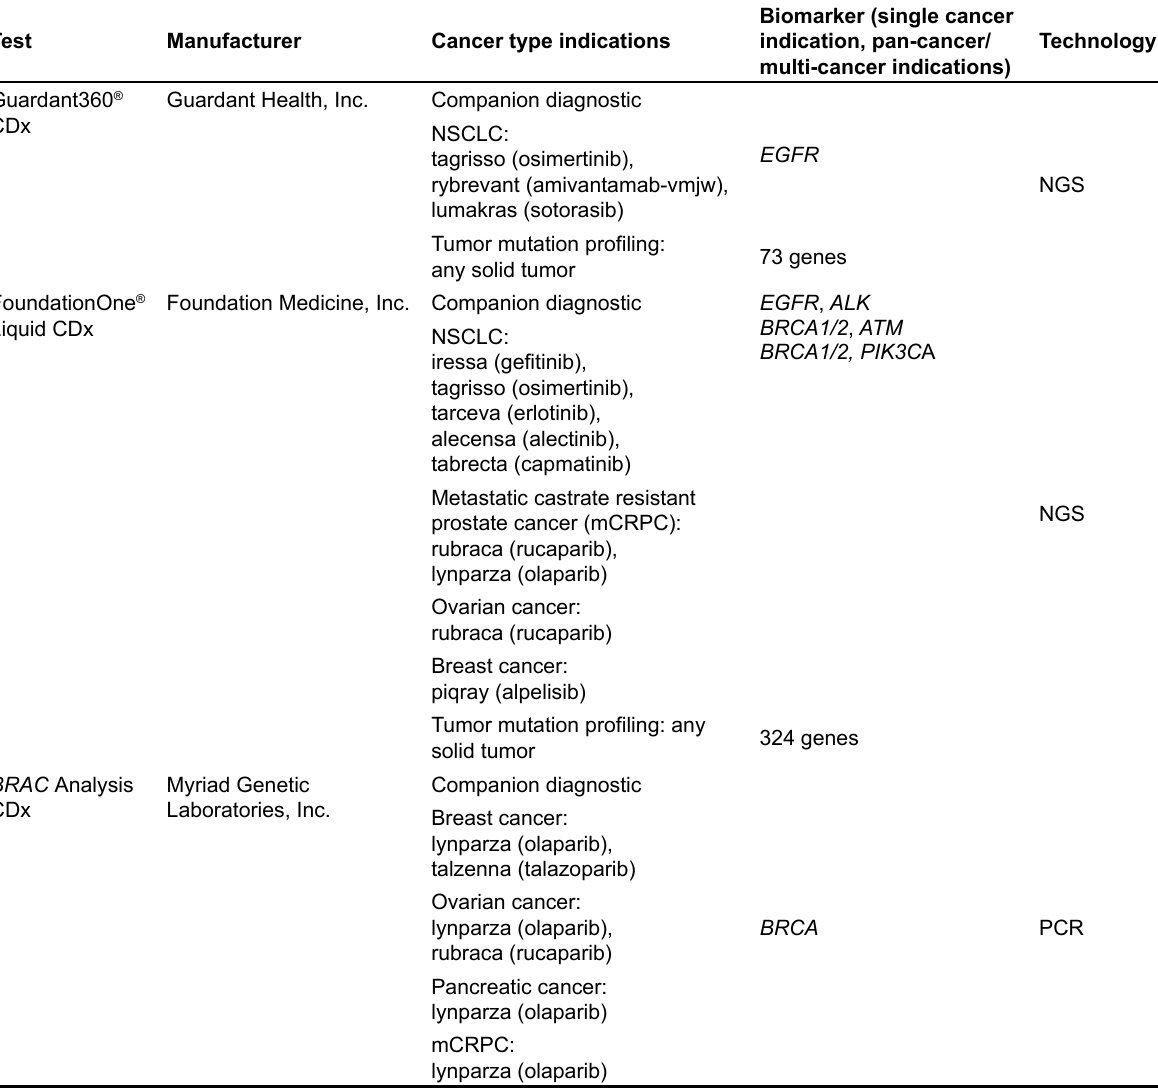
Table 1. Examples of FDA-approved commercial tests for clinical application of ctDNA liquid biopsy ( continued )